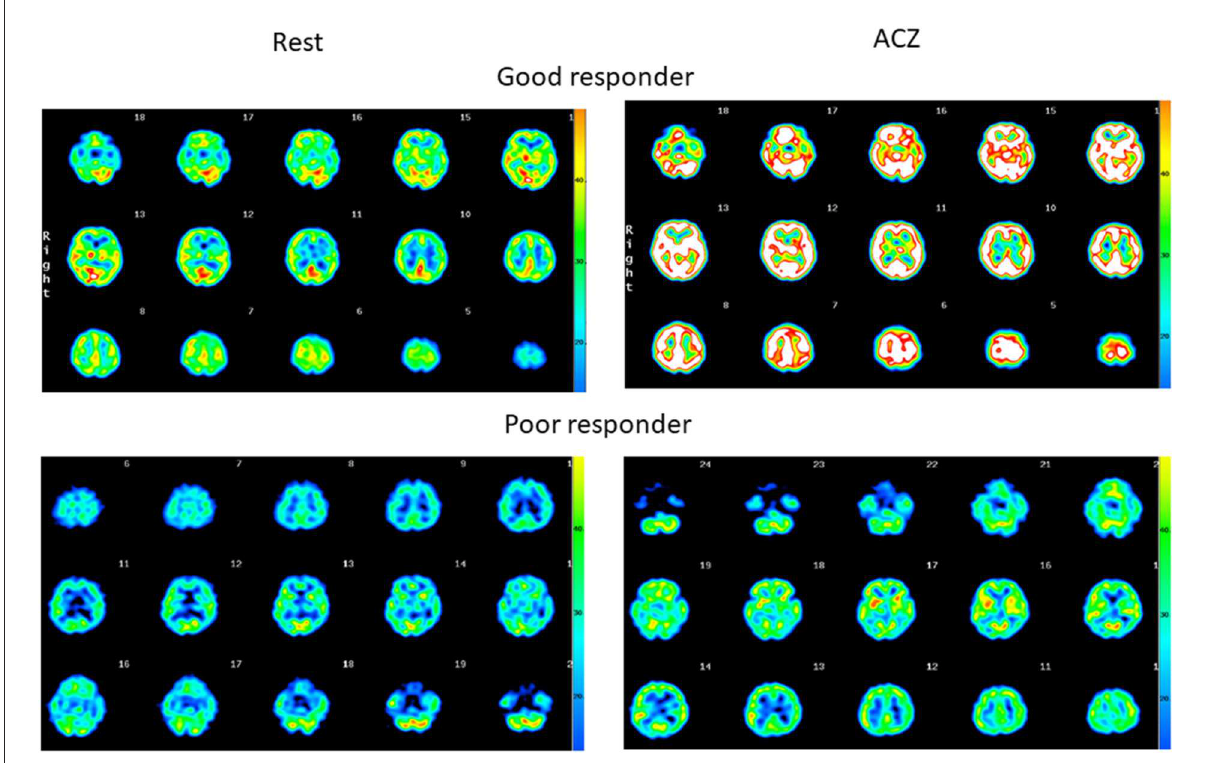
FIGURE1 Quantitative SPECT images at rest and after ACZ injection. (Upper) Diffuse increase in the rCBF, indicating the maintenance in cerebrovasoreactivity in the patient (64-year-old female without stroke). (Lower) Only a slight increase in the rCBF, indicating little residual cerebrovasoreactivity in the patient (42-year-old male with